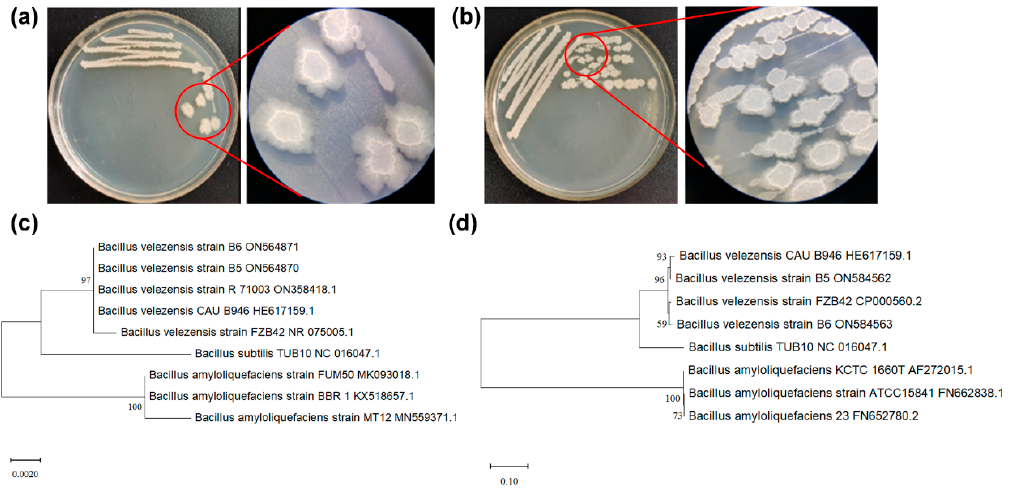
Figure 2. The morphological and molecular identification of strains B5 and B6. Morphological and microscopic observation of strains B5 ( a ) and B6 ( b ). Phylogenetic tree based on the sequences of 16S rRNA gene ( c ) and gyrA gene ( d ).